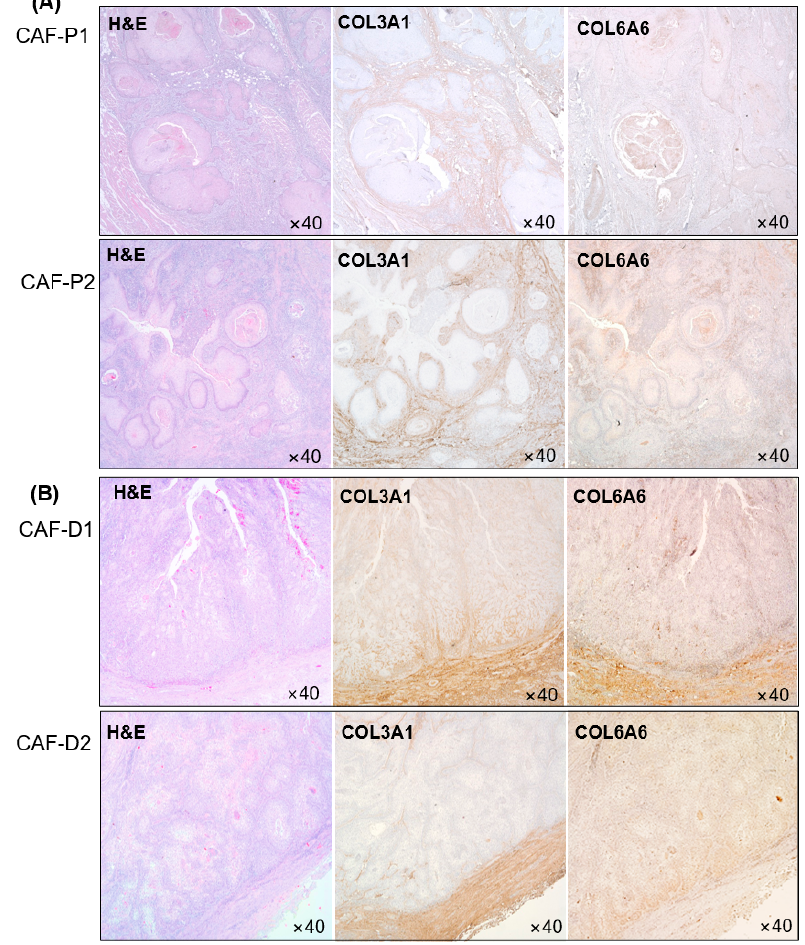
Figure 5. Collagen protein expression in HNSCC patients’ tissues. COL3A1 and COL6A6 protein expression was evaluated in CAF-P ( A ) and CAF-D ( B ) tissues from patients with HNSCC. We compared tumorigenesis in the CAF-P and CAF-D groups upon injection of FaDu spheroids in the oral mucosa of the right (CAF-P) or left (CAF-D) cheek of mice. Interest- ingly, FaDu-derived tumors co-injected with CAF-P were significantly larger than those co-injected with CAF-D (Figure 6A). Figure 6B shows that human-specific Ku80 bi- omarkers were widely stained in tumor tissues, including epithelial cells and fibroblasts, suggesting that FaDu and CAF cells injected into the mice cheeks were well involved in xenograft tumor formation. FaDu-derived mice tumor tissues co-injected with CAF-D showed higher COL3A1 , COL6A6 , COL25A1 , and COL26A1 expression levels than those